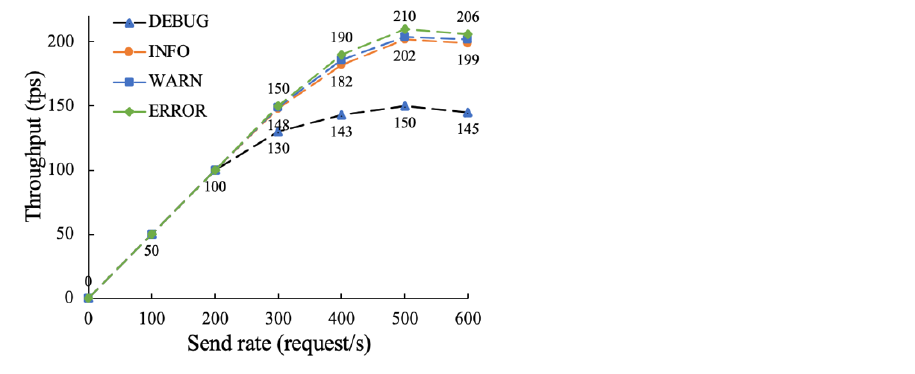
Figure 12. The impact of the Fabric system log level on the throughput performance of the on-chain function.